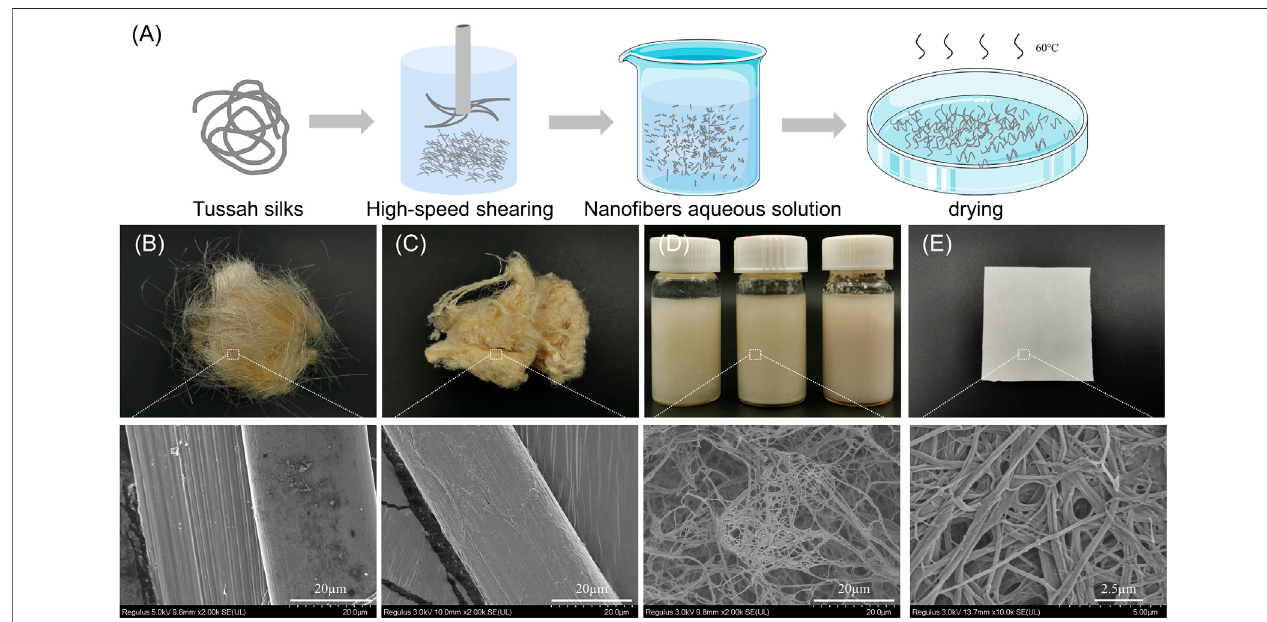
FIGURE1|(A) Preparationprocess oftheTSFnano fi bermat (B) OpticalandSEMphotos oforiginaltussahsilk (C) Opticaland SEMphotosofdegummedtussah silk (D) Optical and SEM photos of aqueous solution of TSF nano fi bers (E) Optical and SEM images of the TSF nano fi ber mat.